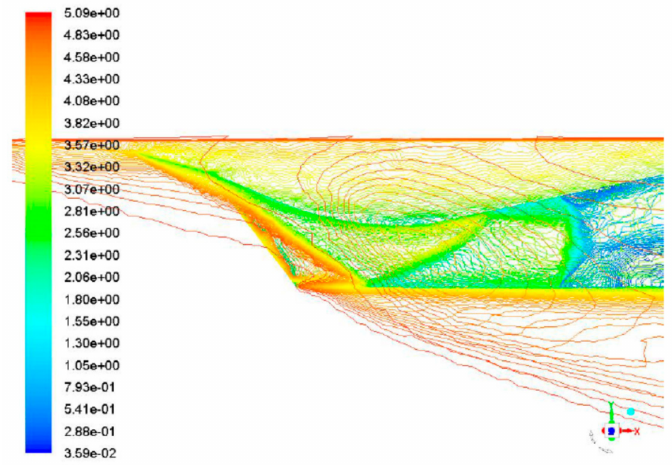
Figure 14. Three-dimensional (3D) shock visualisation.